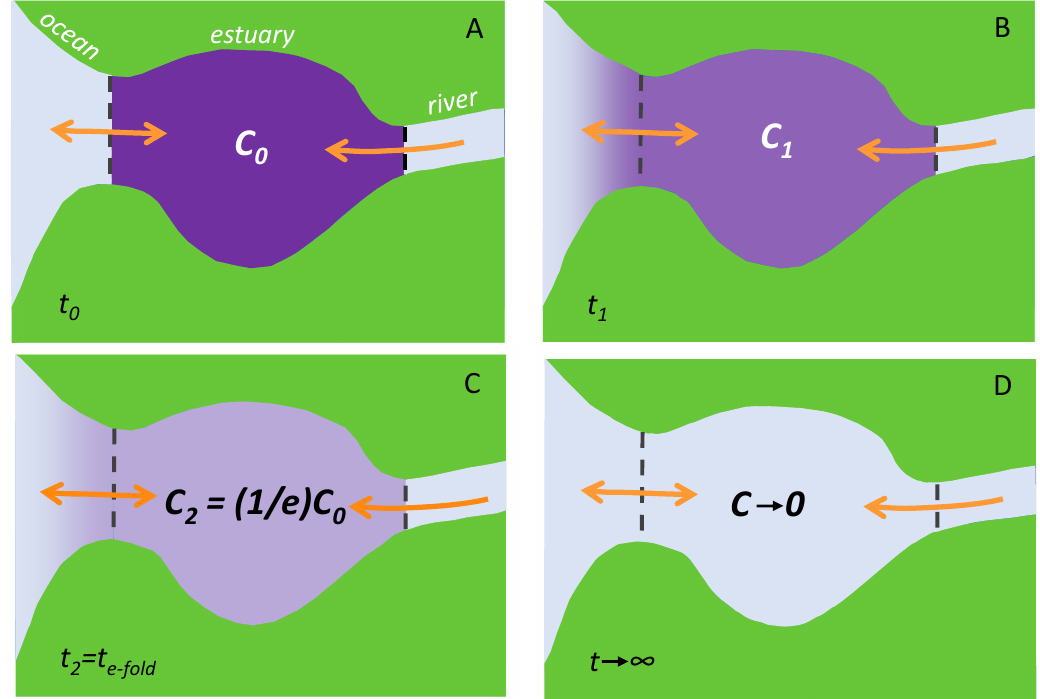
Figure 6. Simplified depiction of the e -folding flushing time, driven by river, tidal, and / or other flushing processes. Panels ( A – D ) follow a progression through time of C , the estuarine concentration of a tracer or other constituent. The e -folding mathematical construct is based on the assumption of perfect mixing within the water body of interest (in this case, the estuary). Dark gray dashed lines represent upstream and downstream boundaries of the estuary. Dark purple represents initial estuarine water. Light gray represents replacement